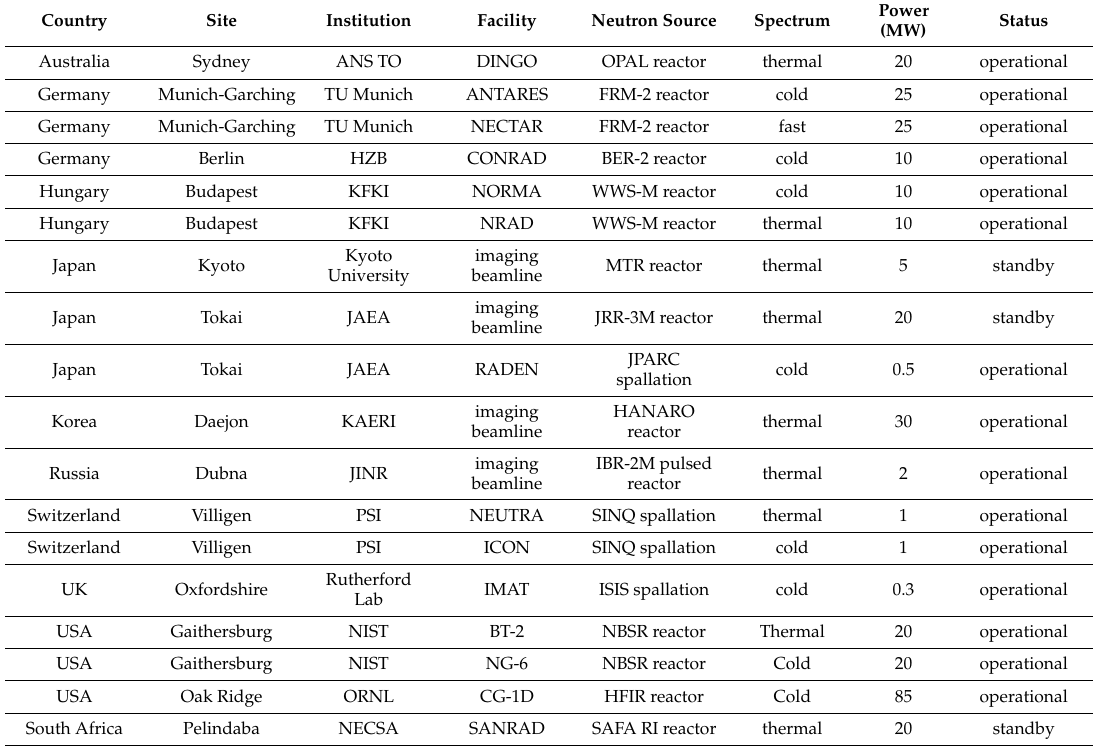
Table 4. List of the “state-of-the-art” NI facilities, reactor and spallation source based; since the spallation process is more efficient in the neutron output than fission, the power is not the direct indicator for performance comparison in these